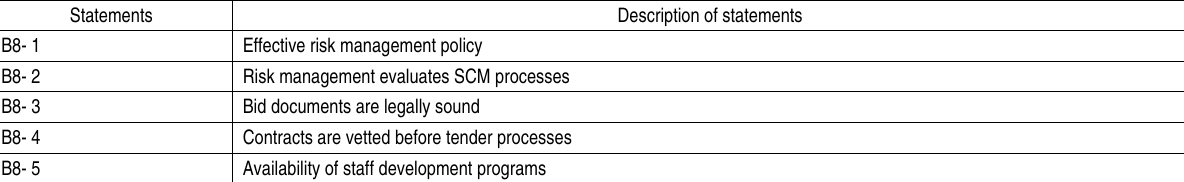
Table 11. Description of statements in Table 10 relating to risk management